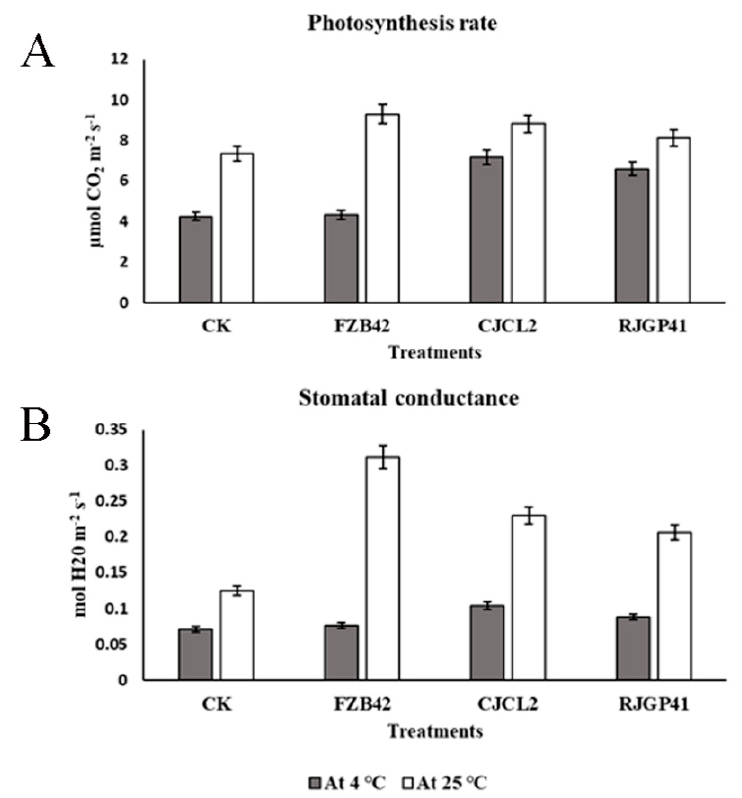
Figure 10. The photosynthesize rate of wheat plants under treatment of different bacterial strains ( A ) Stomatal conductance under the influence of various bacterial treatments in wheat plants ( B ). The error bars represent the standard deviation of the mean ( n = 5). The significant difference among the treatments was observed at p ≤ 0.05 by using Tukey’s HSD test. The experiment was repeated thrice.